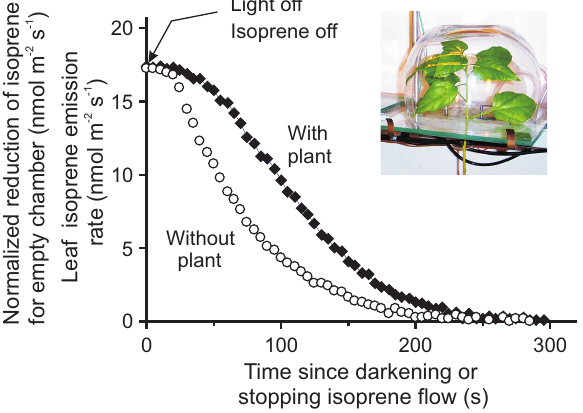
Fig. 5. Comparison of the transient responses of empty chamber and chamber with a hybrid aspen ( Populus tremula × P. tremu- loides , clone 200) plant included (modified from Rasulov et al., 2009a). To assess the transient response of the measurement sys- tem, a stable isoprene flow through the chamber was established using an artificial isoprene source. After the steady-state isoprene flow was reached, isoprene supply was stopped and the system tran- sient response was recorded. In the case of measurements with the plant, the plant was kept at given environmental conditions (light in- tensity of 500µmolm − 2 s − 1 , temperature 28–30 ◦ C) until a steady- state emission rate was established. After reaching the steady-state, light was switched off, and the postillumination isoprene release recorded. The empty chamber system-specific response curve was scaled to given plant isoprene emission rate at steady-state condi- tions. Isoprene emission rate was measured with a Fast Isoprene Analyzer equipped with ozone generator (Hills Scientific, Boulder, CO, USA). The inset shows the 4l glass chamber used in these ex- periments (flow rate was 4lmin − 1 ) .